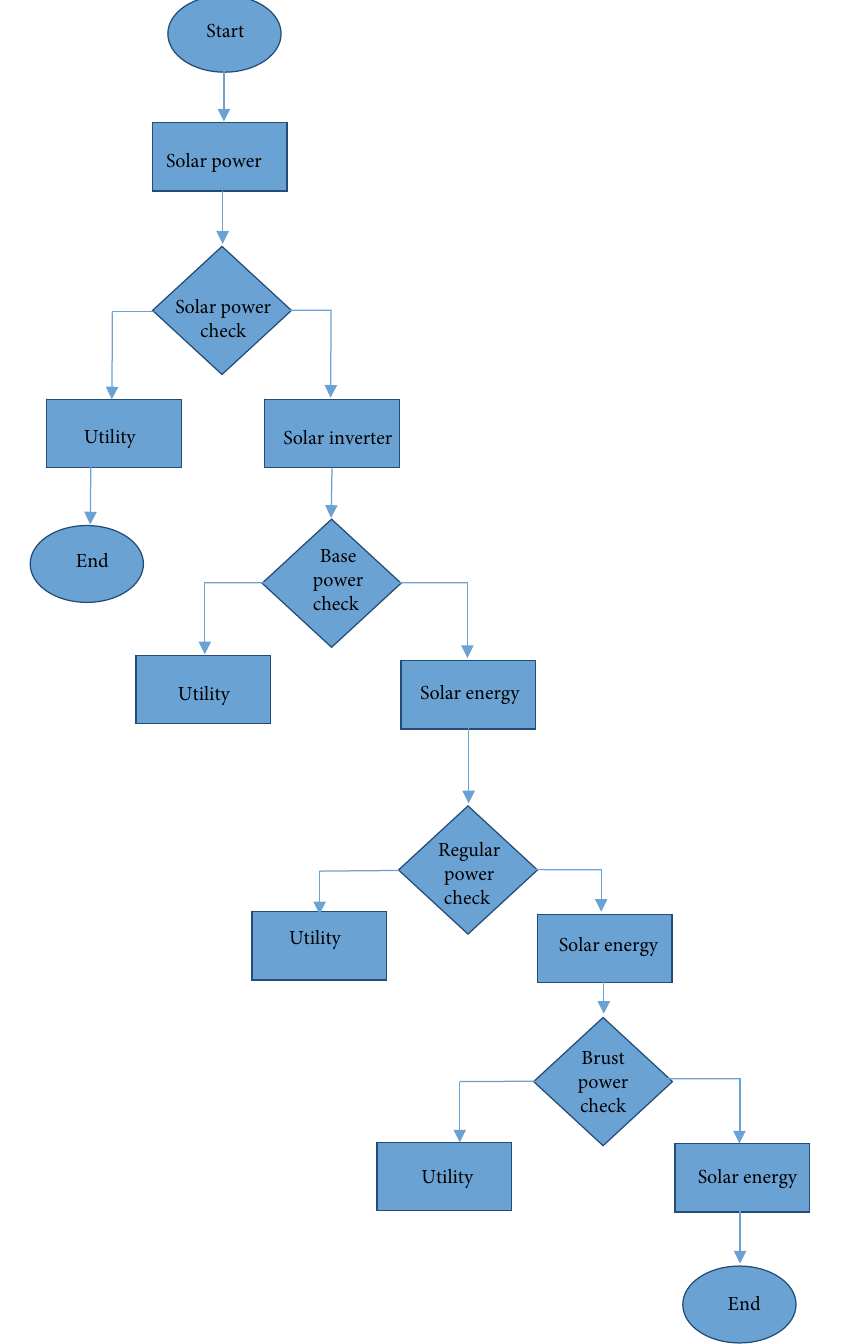
Figure 16: Global controller fl ow